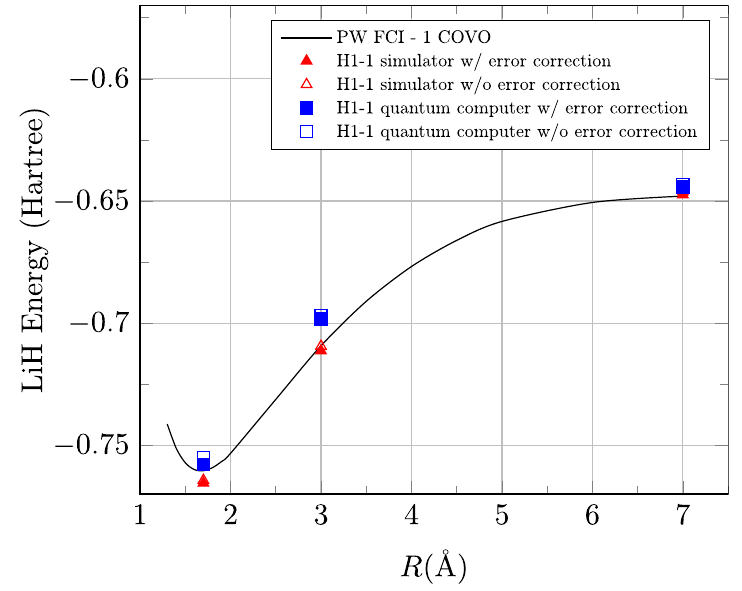
Fig. 6 VQE simulations and calculations on the Quantinuum H1-1 quantum computer. Red triangles correspond to energies obtained with the H1-1 quantum computer simulator, while the blue squares correspond to the energies obtained using the H1-1 quantum computer. Open triangles and square are used to represent energies before error mitigation, while the filled shapes are the error corrected values. We note both the quantum computer and simulator results are very good, and error mitigation has very little effect on the overall results. The energies are plotted with the FCI potential energy curve, given by the solid black line. A simple-cubic supercell (L 15.0 Å) was used =